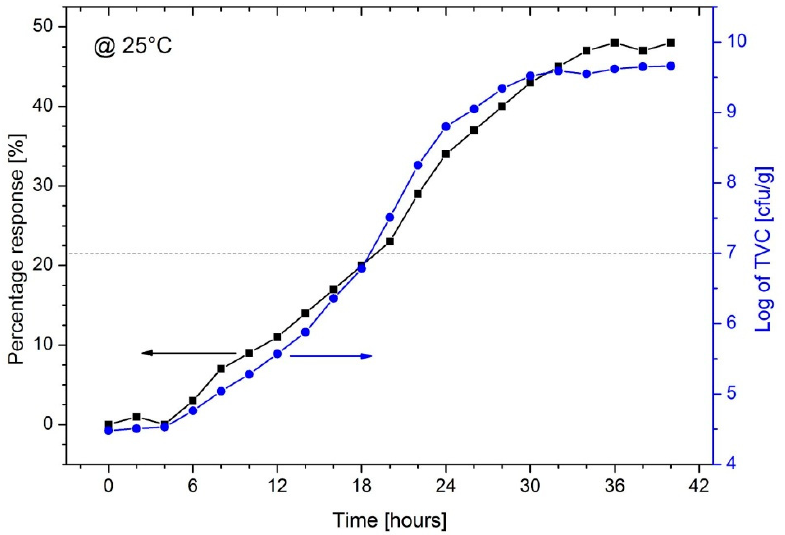
Figure 7. Sensor response (black squares, left scale) and bacterial population (blue circles, right scale) in fresh mackerel fish over a period of 40 h at room temperature (25 °C).